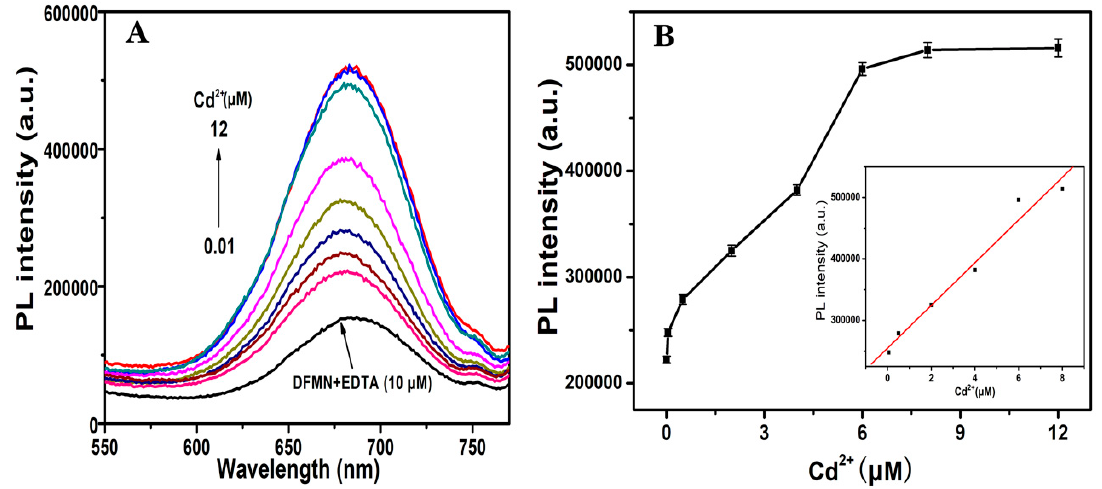
Figure 8. ( A ) fluorescence spectra of DMFN under di ff erent concentrations of Cd 2 + and ( B ) plot of the photoluminescence (PL) intensity of the DMFN as a function of the Cd 2 + concentration.